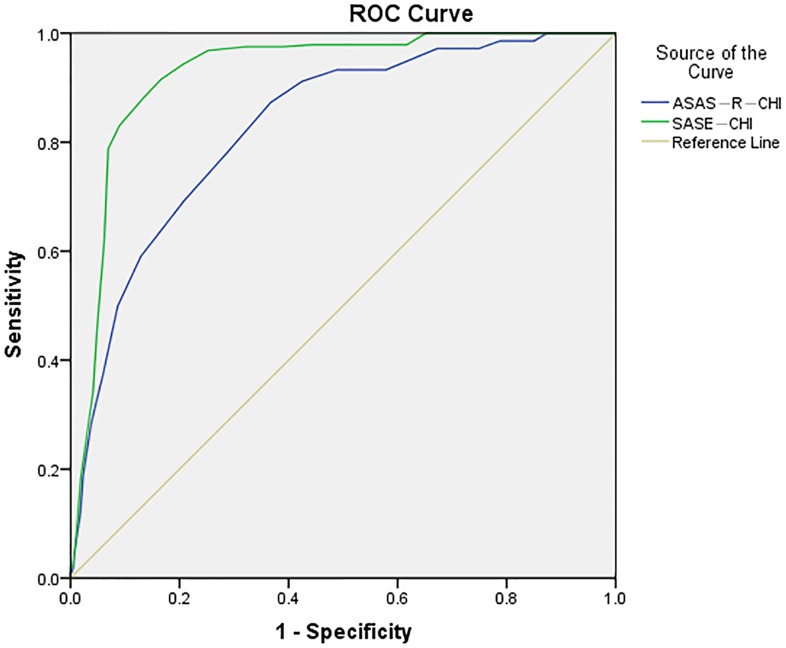
The receiver operator characteristic (ROC) curve of the SASE-CHI and ASAS-R-CHI with ESCA as a criterion (n = 1152).Note. SASE-CHI: the Chinese version of Self-care Ability Scale for the Elderly. ASAS-R-CHI: the Chinese version of the revised form of the Appraisal of Self-care Agency Scale. ESCA: the Exercise of Self-care Agency scale.